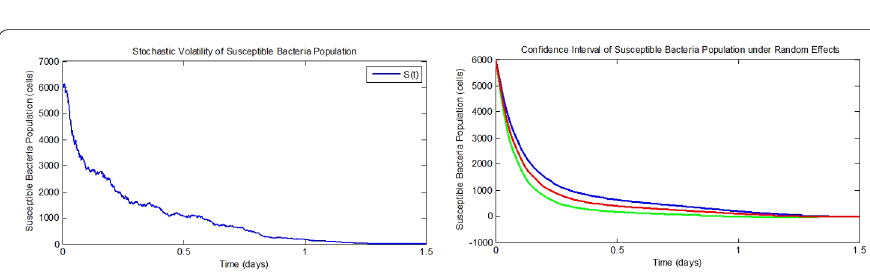
Figure 15 Stochastic volatility and confidence interval of S ( t ), respectively.